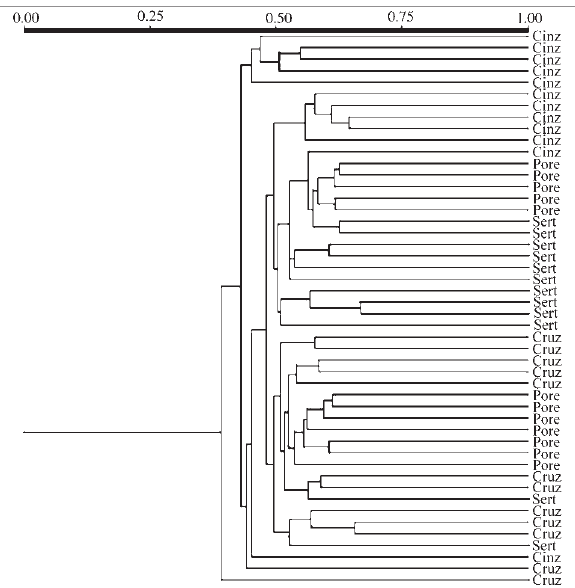
Figure2 -GeneticsimilaritydendrogramgeneratedwiththeJaccardcoef- ficient and UPGMA algorithm for A. altiparanae from the 4 study sites at the Capivara Dam on the Paranapanema R.. CINZ = Cinzas, CRUZ = Cruzália, PORE = Porecatu and SERT = Sertanópolis.